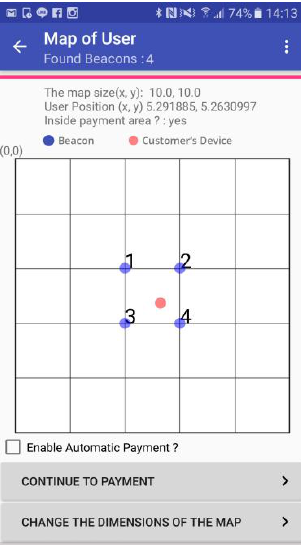
Figure 8. The position-monitoring App shows the current position of the corresponding smartphone in the map of a target payment-enabled area.